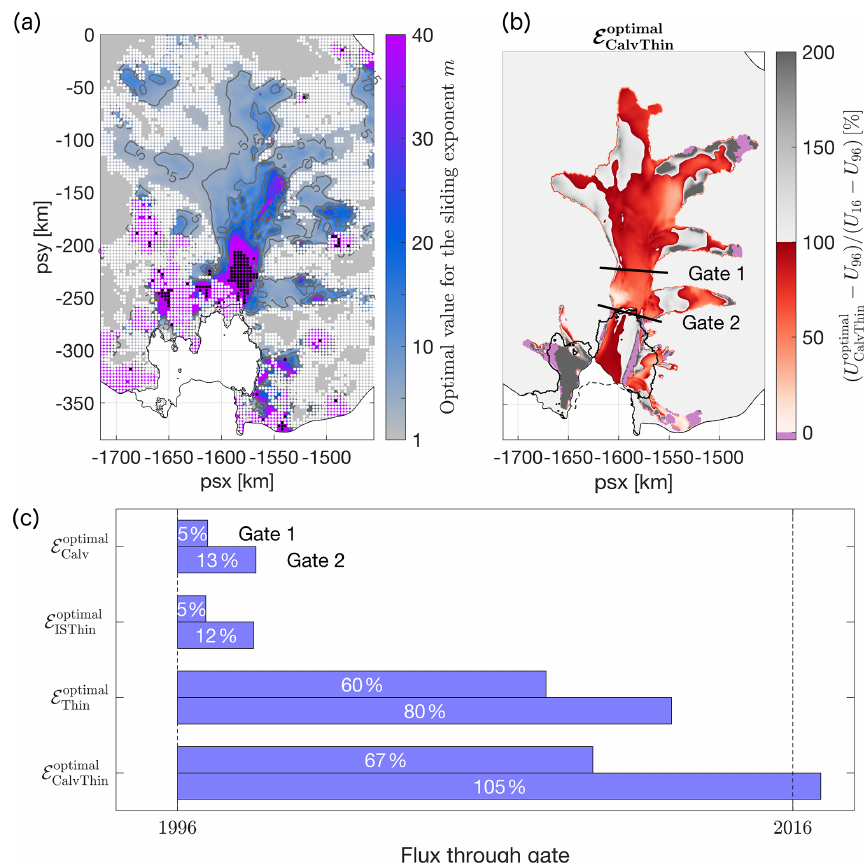
Figure 6. (a) Optimal values of the sliding exponent, required to ensure close agreement between modelled and observed changes in flow ve- locity of Pine Island Glacier between the years 1996 and 2016. White and black dots mark areas where such an agreement cannot be achieved /(U 16 − U 96 ), m i ∈ { 1 , 3 , ··· , 21 } , for different reasons: white dots indicate a poor fit between the transfer function | T US | and (cid:49)U m i CalvThin with R 2 < 0 . 9; black dots indicate areas where a positive, finite solution for m optimal in Eq. (7) does not exist and non-linear viscous sliding cannot reproduce observed changes in surface flow. (b) Same as Fig. 3d but for optimal values of the sliding-law exponent in panel (a) . (c) Same as Fig. 3e but for optimal values of the sliding-law exponent in panel (a)